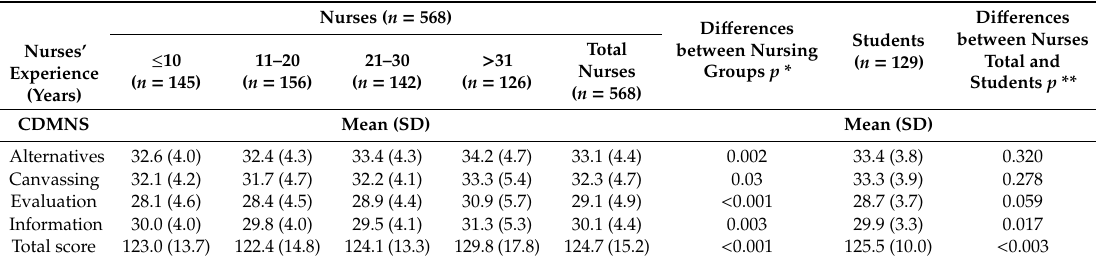
Table 2. Di ff erences in nurses’ decision-making according to their work experience, and between nurses and